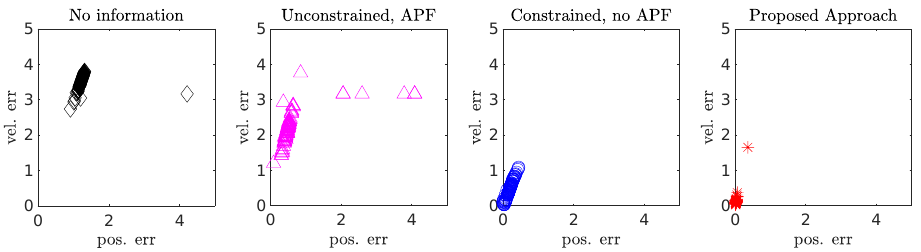
Figure 3. Ensemble view of the (relative) position and velocity error values over 100 runs (i.e., see Equations (20) and (21)), considering the four operative